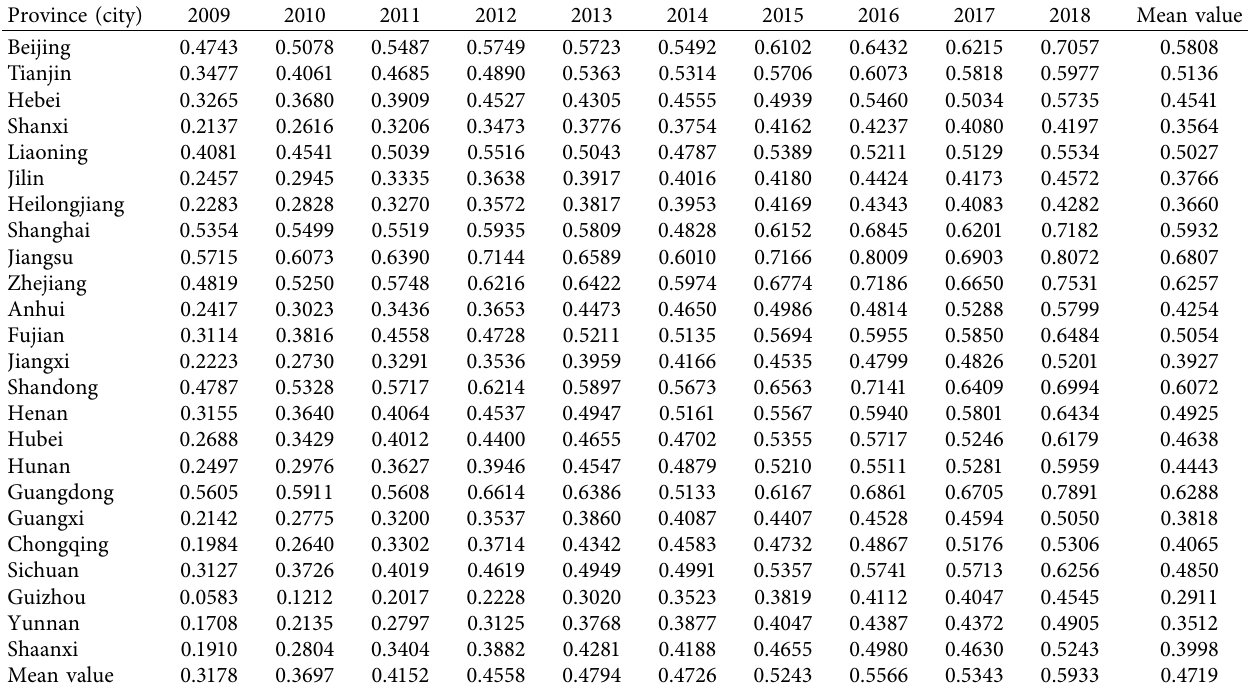
Table 7: Coupling coordination degree of 24 provinces